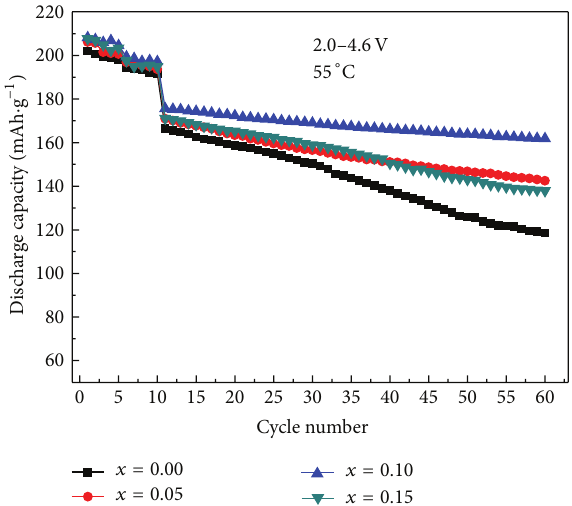
Figure 4: Cyclic performance of LiNi 1/3 Co 1/3 Mn 1/3 O 2−𝑥 Cl 𝑥 cath- ode materials at different rates.